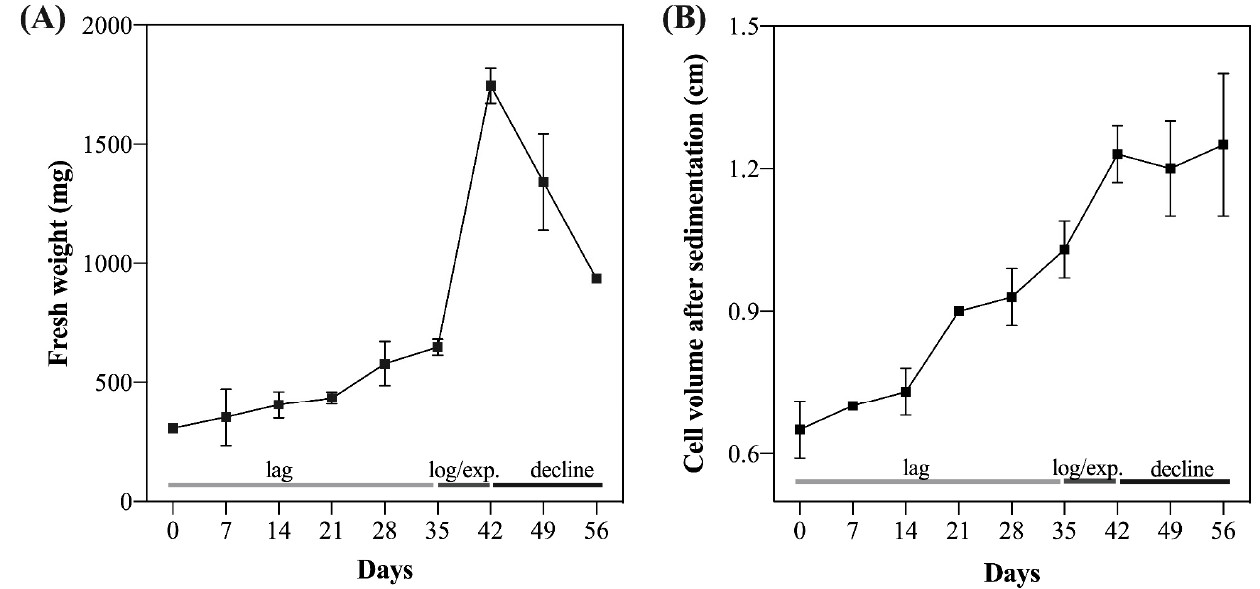
Figure 1. Growth dynamics of G. chacoensis embryogenic cultures measured by a destructive method ( A ) and non-destructive method ( B ). ( A ) Growth determined by fresh weight measurement (mg mg − 1 ) and ( B ) growth determined by cell volume after sedimentation (CVS) (cm). Bars indicate the standard deviation of the mean. Lag: lag phase; log/exp: logarithmic or exponential phase; decline: decline phase.